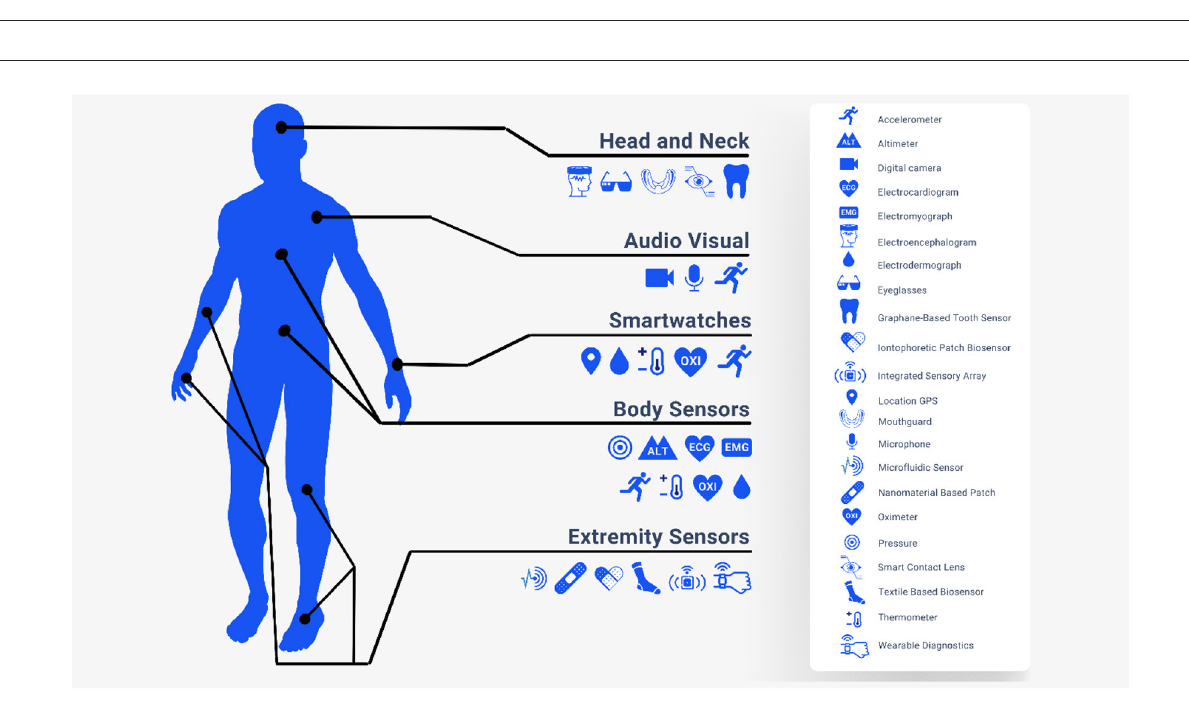
FIGURE2 Health Internet of Things